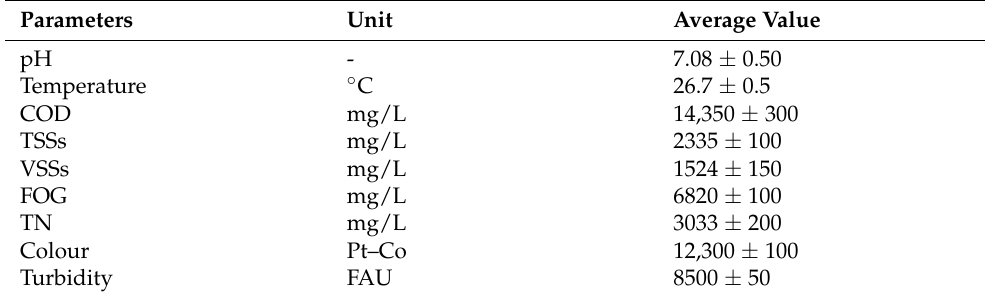
Table 1. The initial composition of